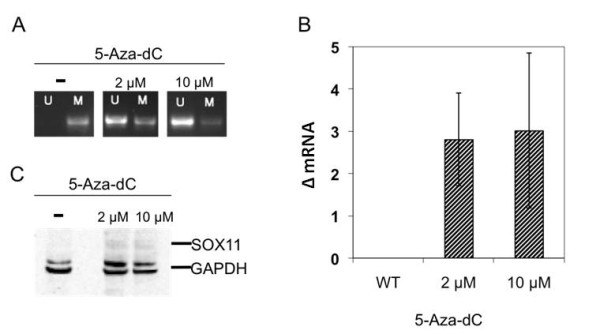
Induced expression of SOX11 in ES-2. (A) Treatment of the ovarian cancer cell line ES-2 with 5-Aza-dC for 96 h led to demethylation of the SOX11 promoter. (B) SOX11 mRNA can be detected above background level by qRT-PCR. (C) SOX11 protein expression as determined by Western Blot analysis. The data shown here is a representative example of three independent experiments.